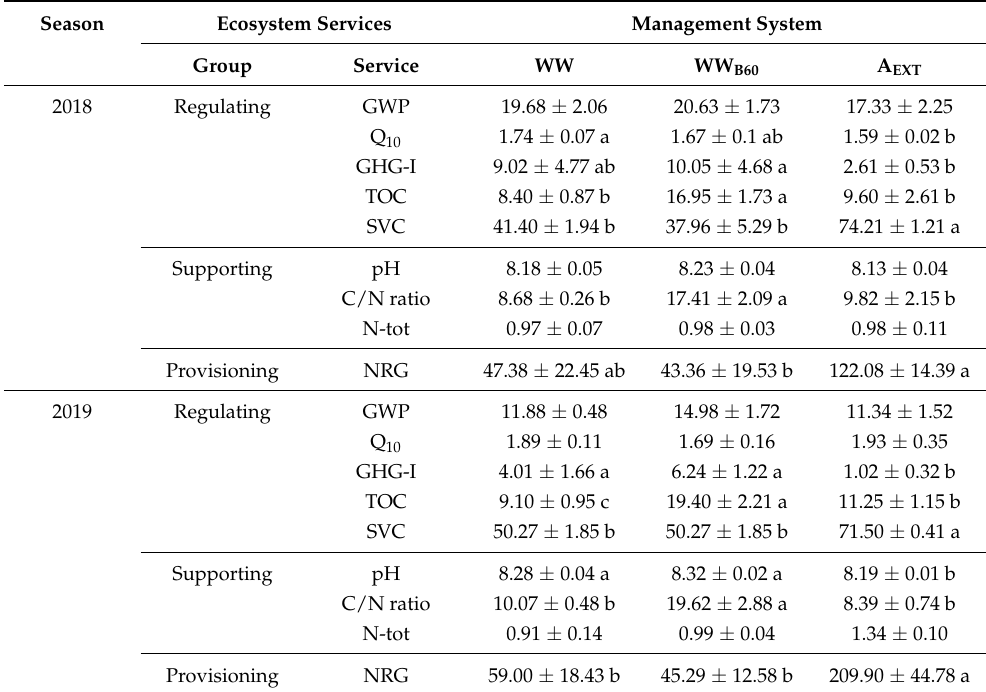
Table 2. Indicators of ecosystem services as influenced by the management systems across the two